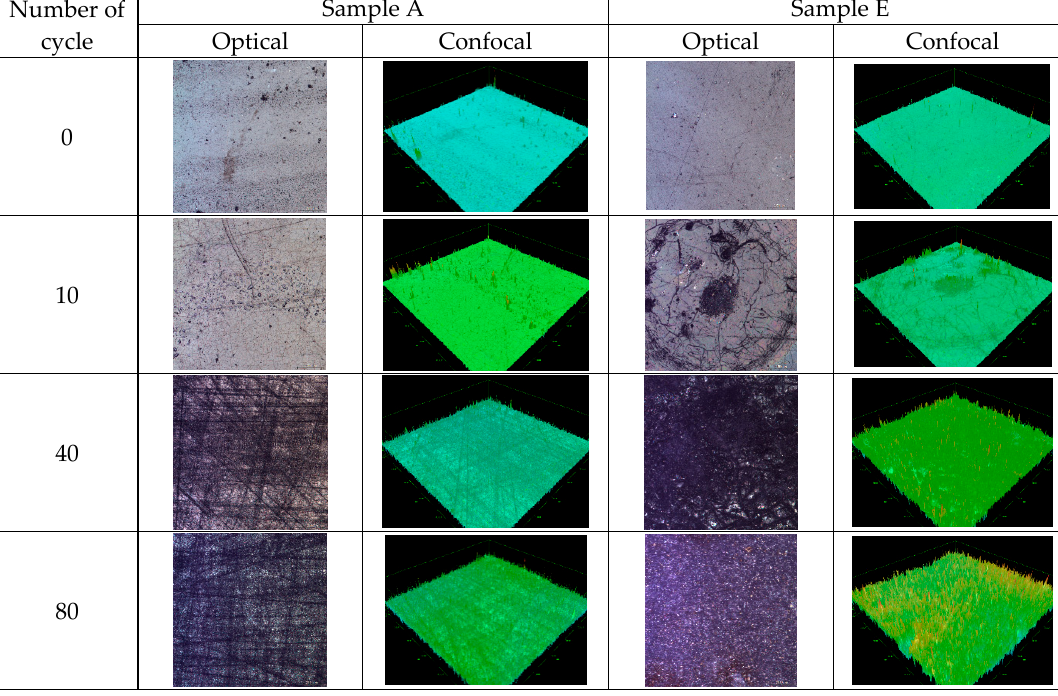
Figure 5. Optical and confocal microscope images of surface of samples A and E obtained in the 100-cycle test with 1 mm air gap.